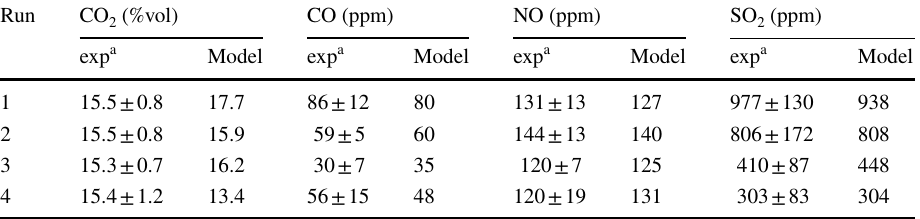
Notes : a based on the experiments presented by Varol et